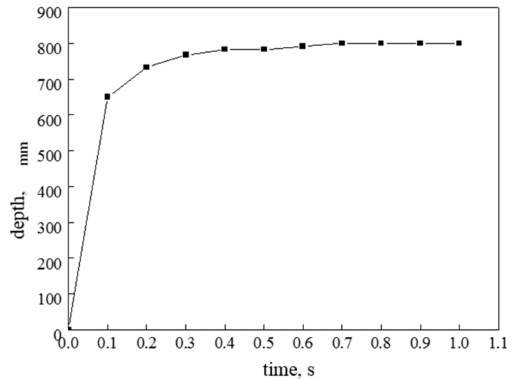
Figure 4. Variation of raceway depth with blowing